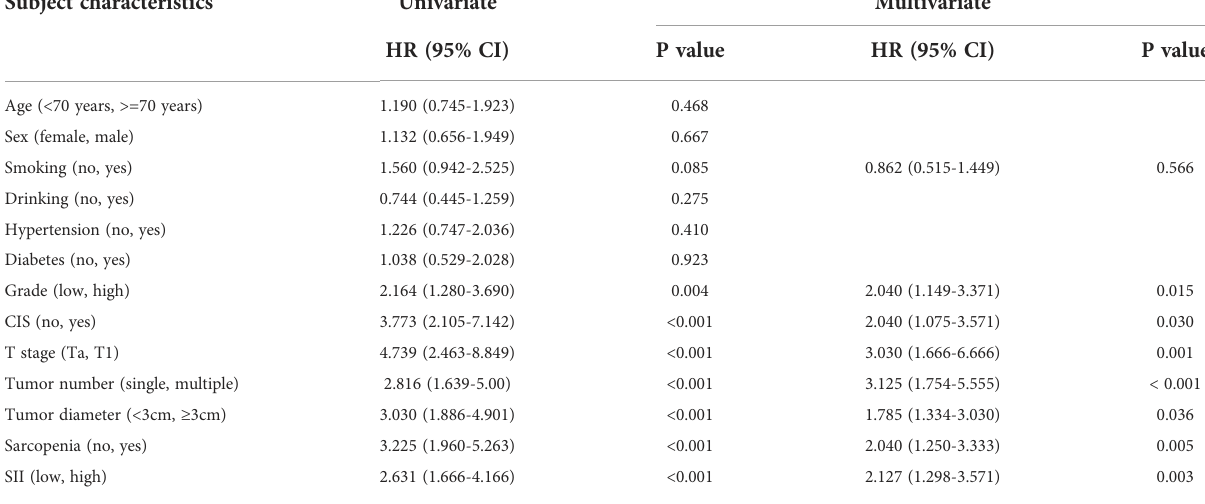
TABLE 3 Univariable and multivariable cox analyses of